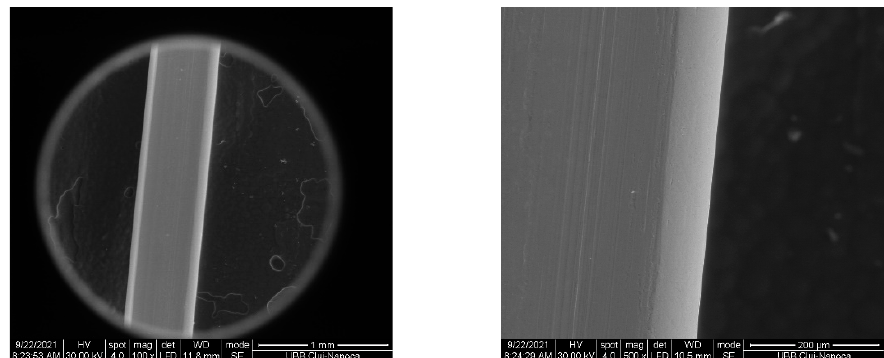
Figure 7. SEM image of the archwire after the test, with magnification at 100× and